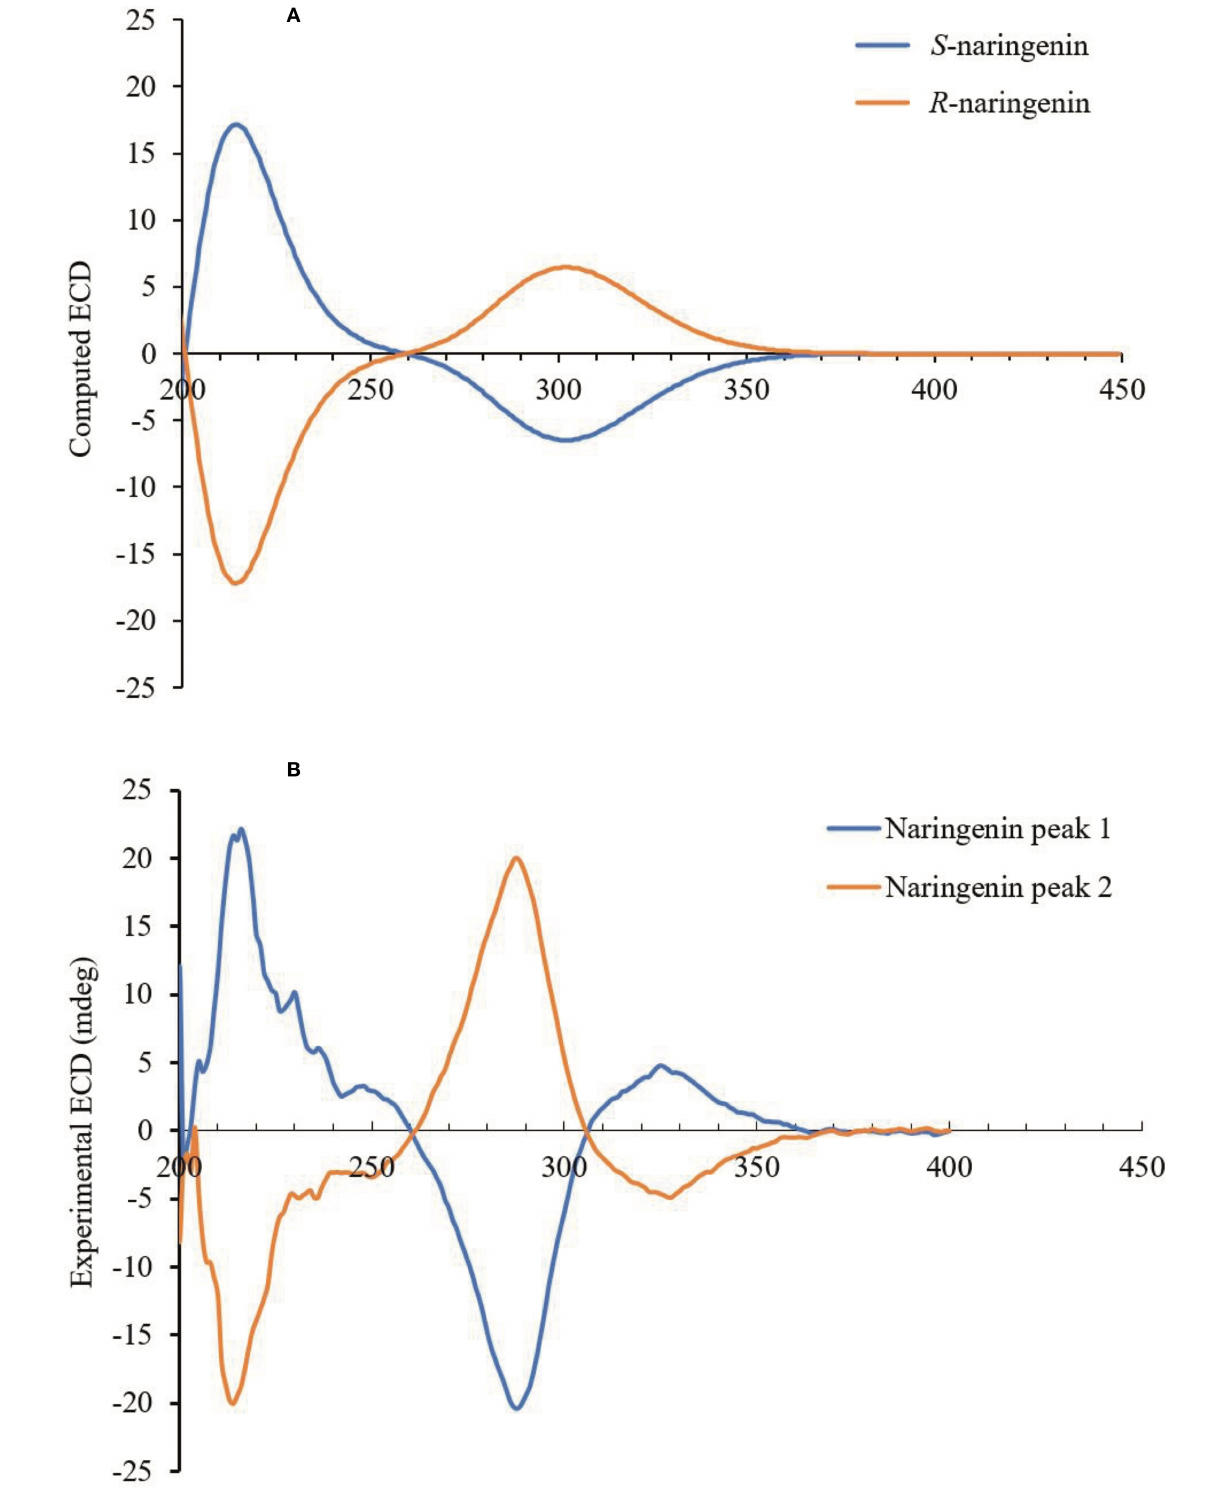
Frontiers in Nutrition |